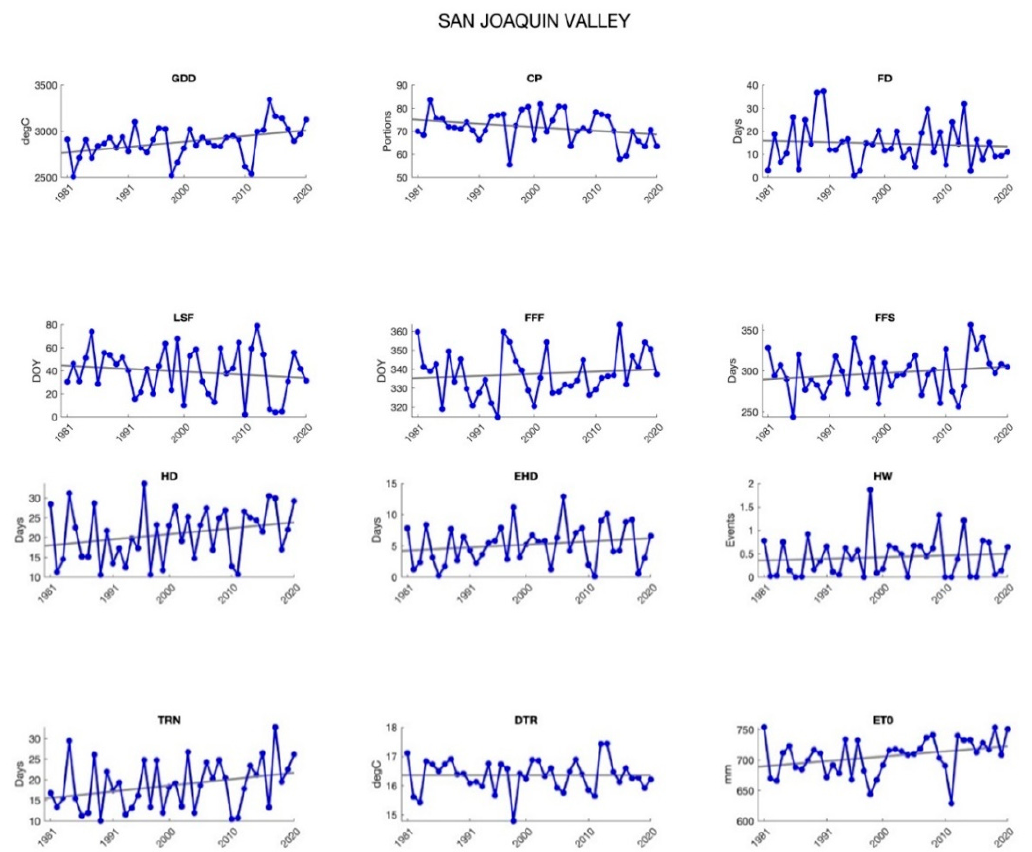
Figure A5. Annual agroclimate metrics averaged over the San Joaquin Valley region with linear trendline. Metrics are shown as: row 1: growing degree days (GDD), chill portions (CP), frost days